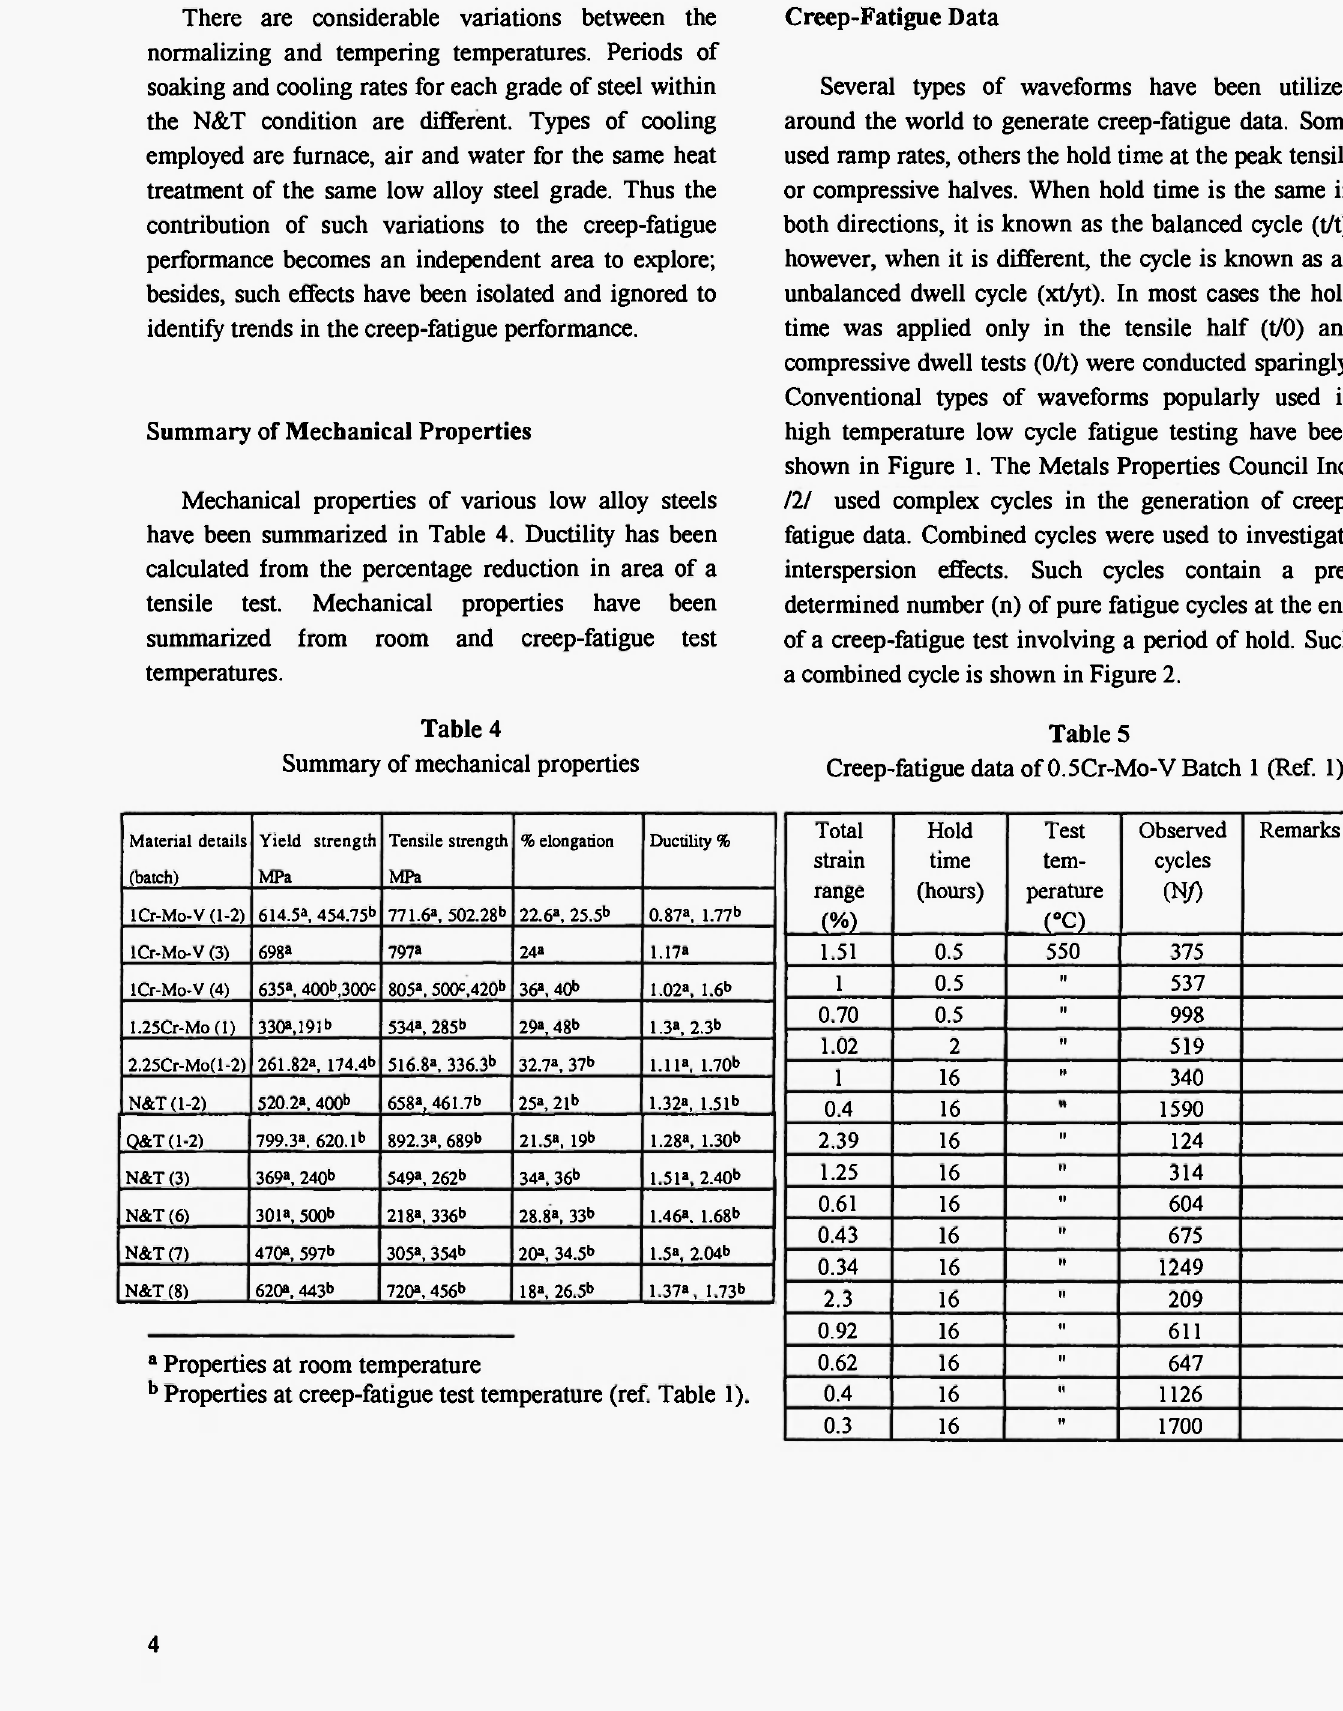
Creep-fatigue data of 0.5Cr-Mo-V Batch 1 (Ref.